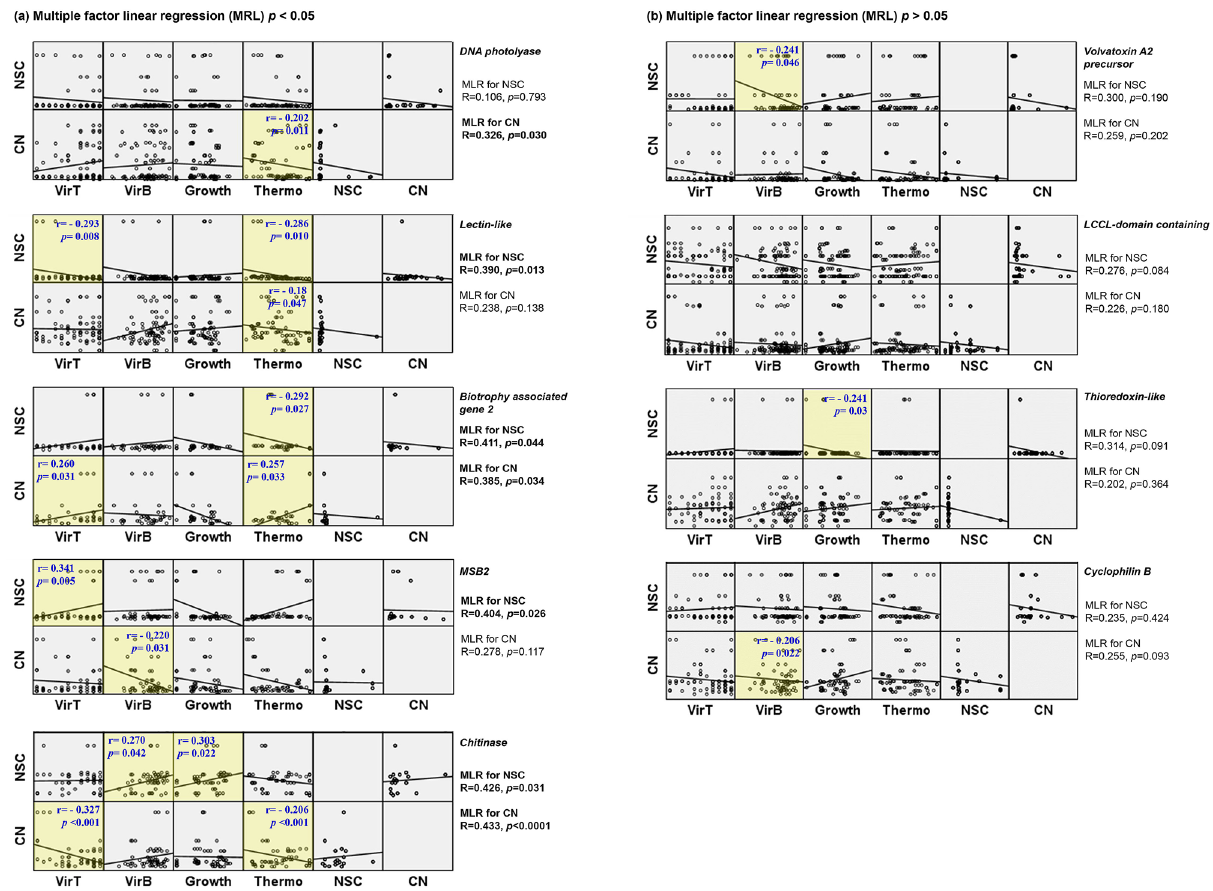
Figure 5. Multiple factor linear regression (MRL) model to describe the correlation between four fungal phenotypic variables [Virulence against T. molitor (VirT) and B. tabaci (VirB), fungal growth (Growth) and thermotolerance (Thermo)] and genotypic dependents (NSC (nonsynonymous change) or CN (copy number)). Genes were divided into significant ( p < 0.05) MRL group ( a ) and non-significant ( p > 0.05) MRL group ( b ). In each gene, regression coefficient and p value of MRL was provided at the right of the multi scatter plot. Additionally, simple linear regression was conducted between each individual variable and dependent, and significant simple regression ( p < 0.05) was marked with yellow background. Pearson r and p values were represented for each of the statistically significant simple linear regression. The different graphs were plotted using SPSS program ver. 19.0 (SPSS, Inc, Chicago, IL,